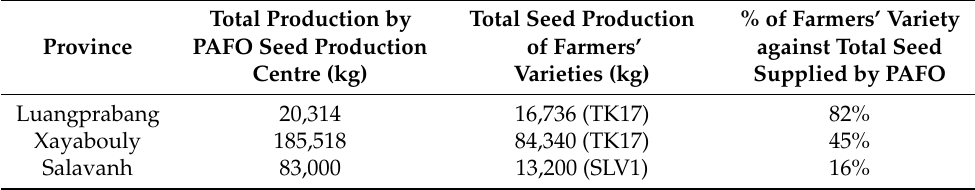
Table 1. Amounts of farmers’ varieties supplied by PAFO in three